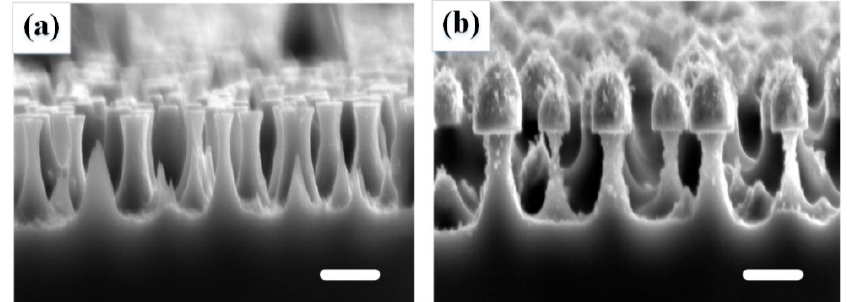
Figure 4. Cross-sectional SEM images of the nanostructures ( a ) without Ag NPs and ( b ) with Ag NPs after the ICP process. Scale bar corresponds to 500 nm.